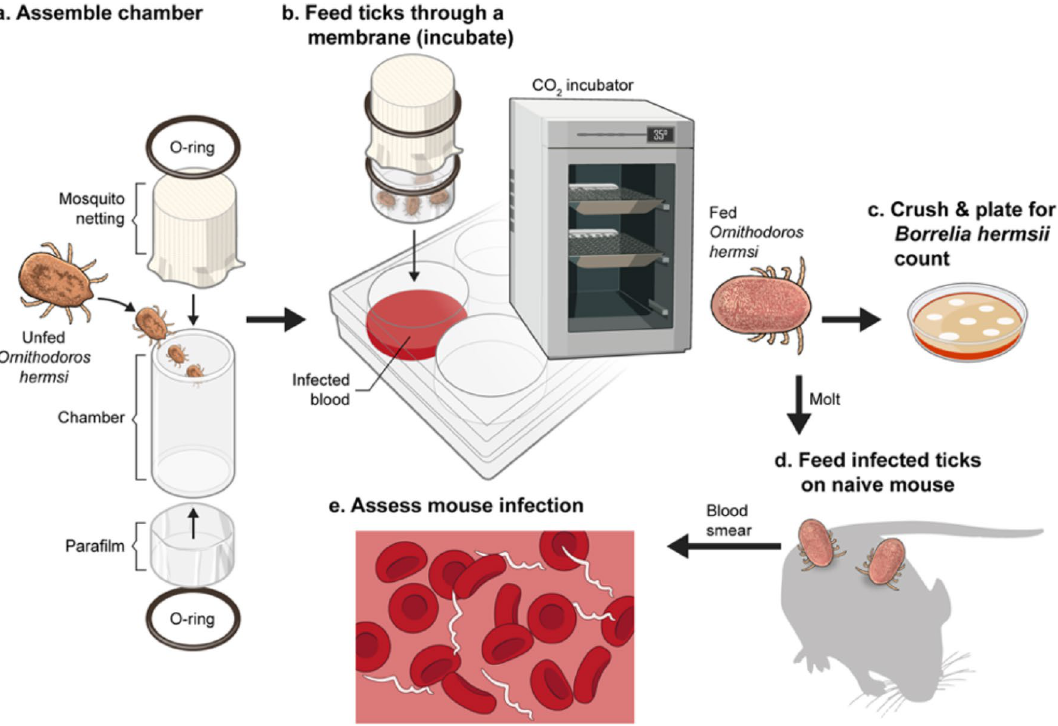
Figure 2. Overview of experimental strategy. ( a ) O. hermsi ticks were placed in the artificial membrane chambers and ( b ) allowed to feed on infected blood. ( c ) A portion of the fed ticks were pulverized in liquid medium and diluted into solid medium to calculate spirochete densities. ( d ) The remaining ticks were allowed to molt and then to feed on naïve mice, after which B. hermsii transmission was assessed by examining mouse blood for spirochetemias ( e